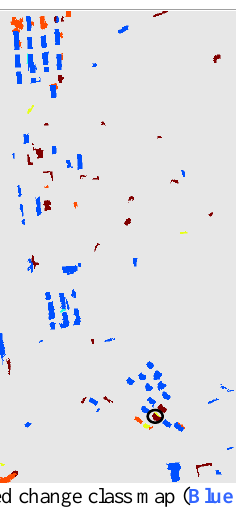
Figure 11. Detected change class map ( Blue : built before 2009; Yellow: built before May 2010; Orange: built before January 2011; Dark red: built before May.